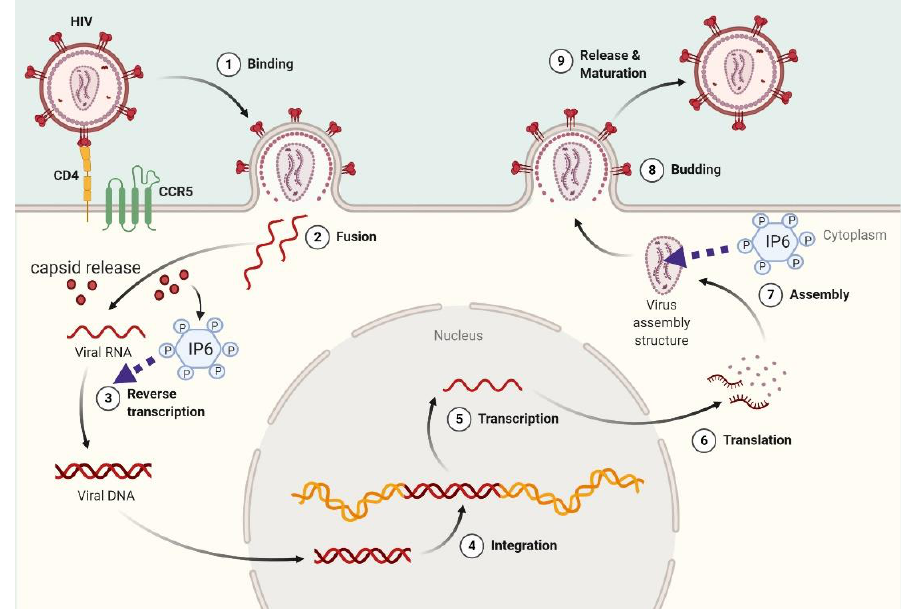
Figure 3. Mechanistic model for Ins P 6 functions in HIV-1 infection. After virus infection, capsids are released into the cytoplasm and Ins P 6 maintains capsid integrity. Before the budding phase, Ins P 6 is recruited in assembling virions.